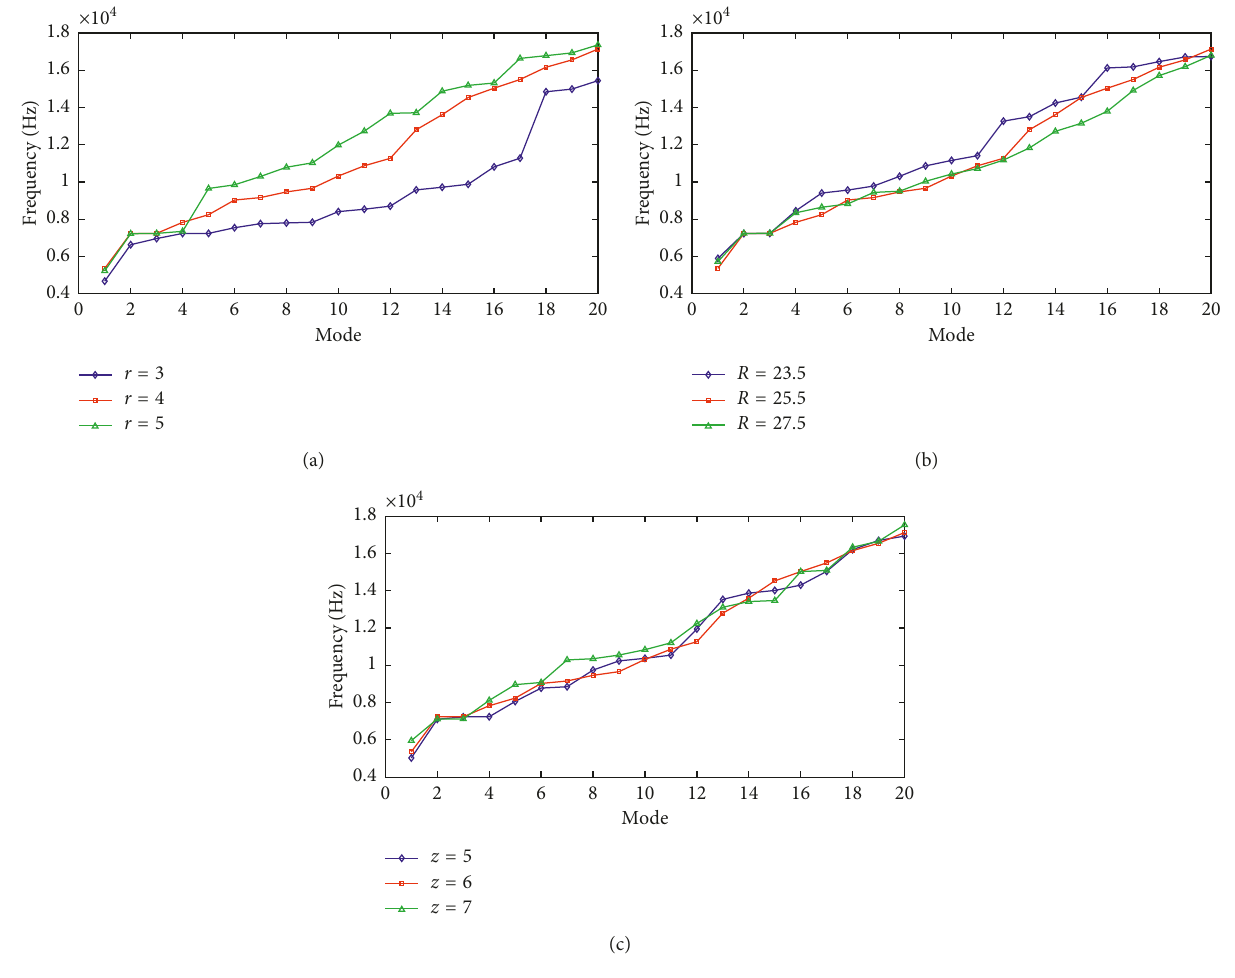
Figure 10: Natural frequencies as functions of the system